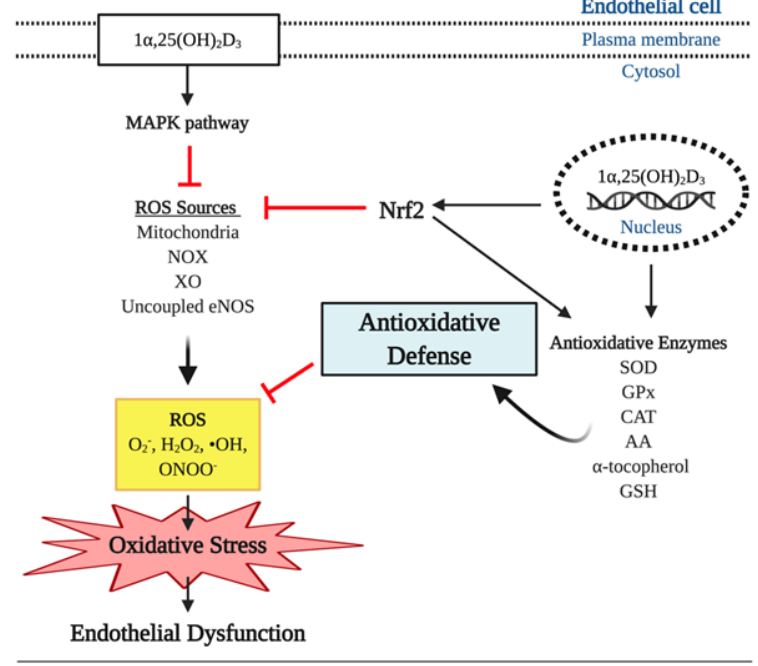
Figure 3. Antioxidant e ff ect of vitamin D and endothelial function. In pathophysiological conditions, overproduction of reactive oxygen species (ROS), such as superoxide anion (O 2 − ), hydrogen peroxide (H 2 O 2 ), hydroxyl radical ( • OH), and peroxynitrite (ONOO − ), outbalances antioxidative defenses and causes oxidative stress, which is implicated to development of endothelial dysfunction. In the cell, ROS are produced by various intracellular sources including mitochondria, nicotinamide adenine dinucleotide phosphate (NADPH) oxidase (NOX), xanthine oxidase (XO), and uncoupled endothelial nitric oxide synthase (eNOS). Vitamin D elicits antioxidant e ff ects through upregulating expression of antioxidative enzymes including superoxide dismutase (SOD), glutathione peroxidase (GPx), catalase (CAT), ascorbic acid (AA), α -tocopherol, and glutathione (GSH) that can scavenge the free radicals. In addition, the genetic action of vitamin D triggers the expression of nuclear respiratory factor 2 (Nrf2), a key transcriptional factor that suppresses ROS production from its various sources and upregulates the expression of the antioxidative enzymes.